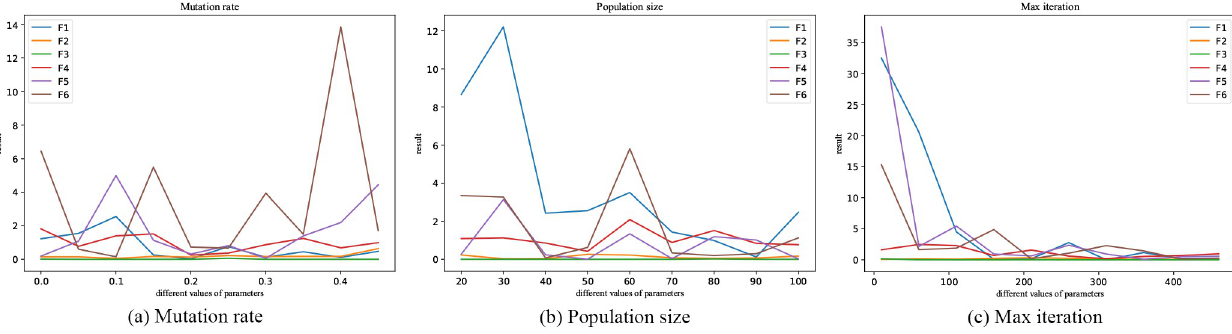
ffiffiffiffiffiffiffiffiffiffiffiffiffiffiffiffiffiffiffiffiffiffiffiffiffiffiffiffi p ffiffiffiffiffiffiffiffiffiffiffiffiffiffiffiffiffiffiffiffiffiffiffiffiffiffiffiffi þ ð y þ 47 Þj j x 2